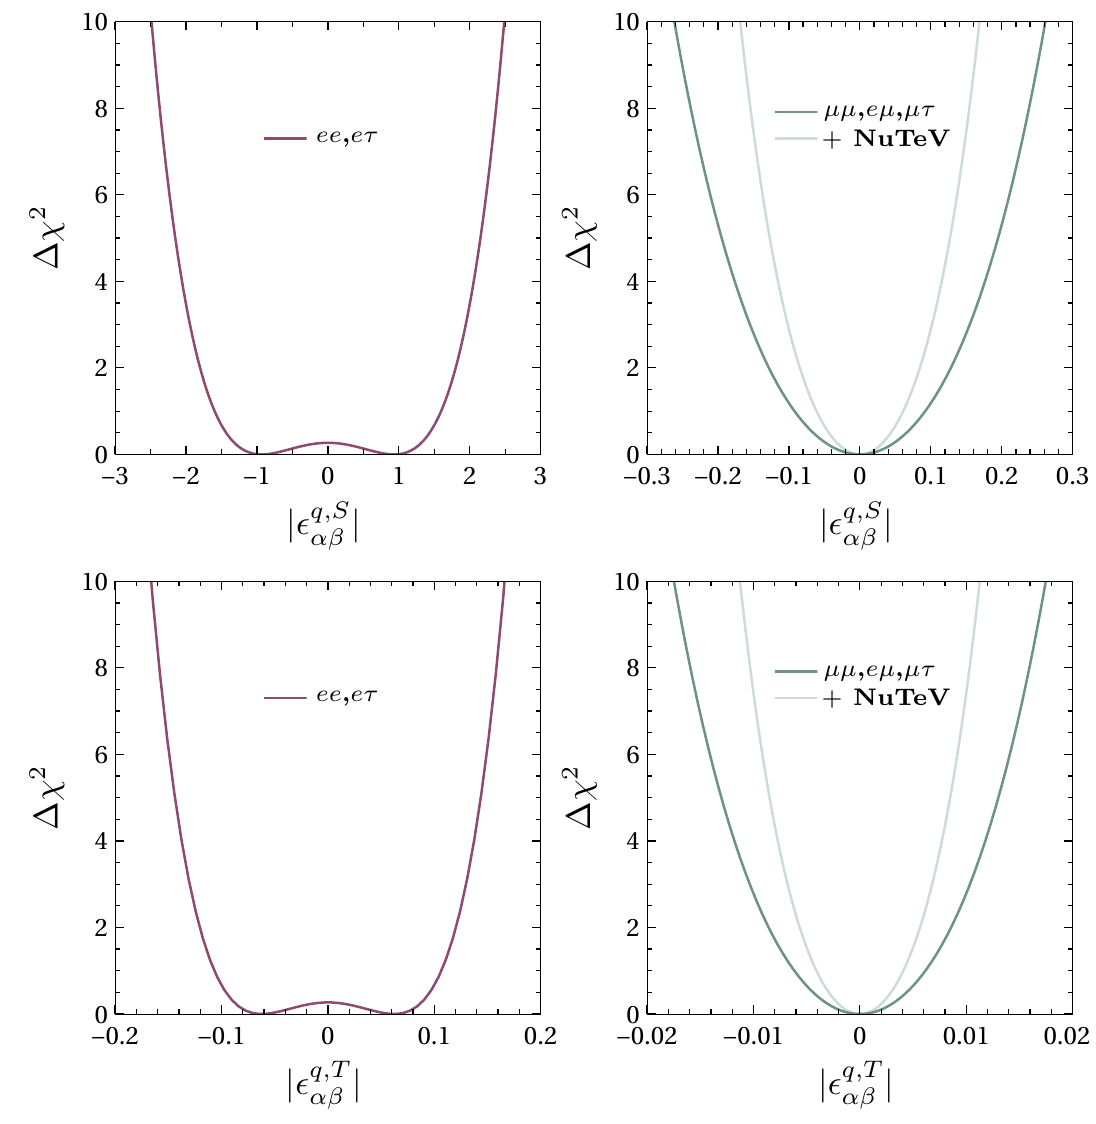
Figure 3 . Global constraints on the neutrino-quark interaction parameters from different experi- ments. The upper (lower) panels correspond to the scalar (tensor) parameters. In the right panels we present the resulting limits without the NuTeV measurement (solid green line) and including it (solid gray